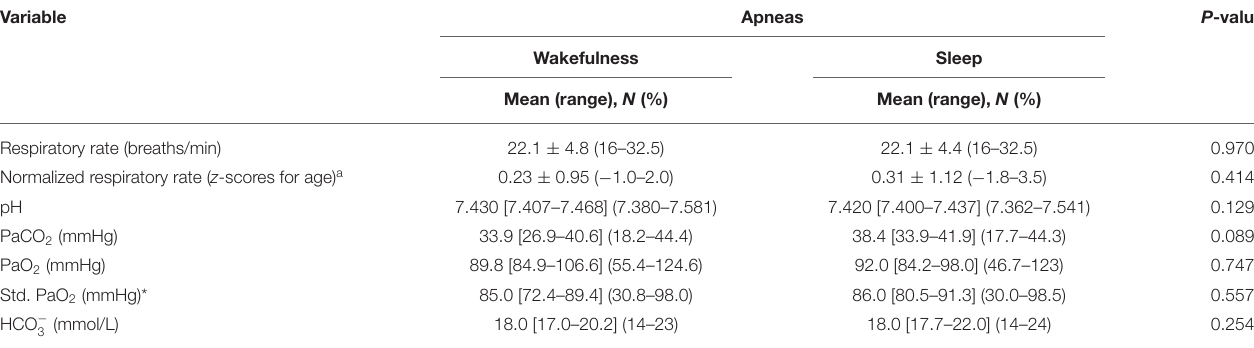
TABLE 7 | Respiratory and arterial blood gas analysis data of the examined patients with RTT as a function of wakefulness ( n = 17) vs. sleep apneas ( n = 49). Variable Apneas P -value